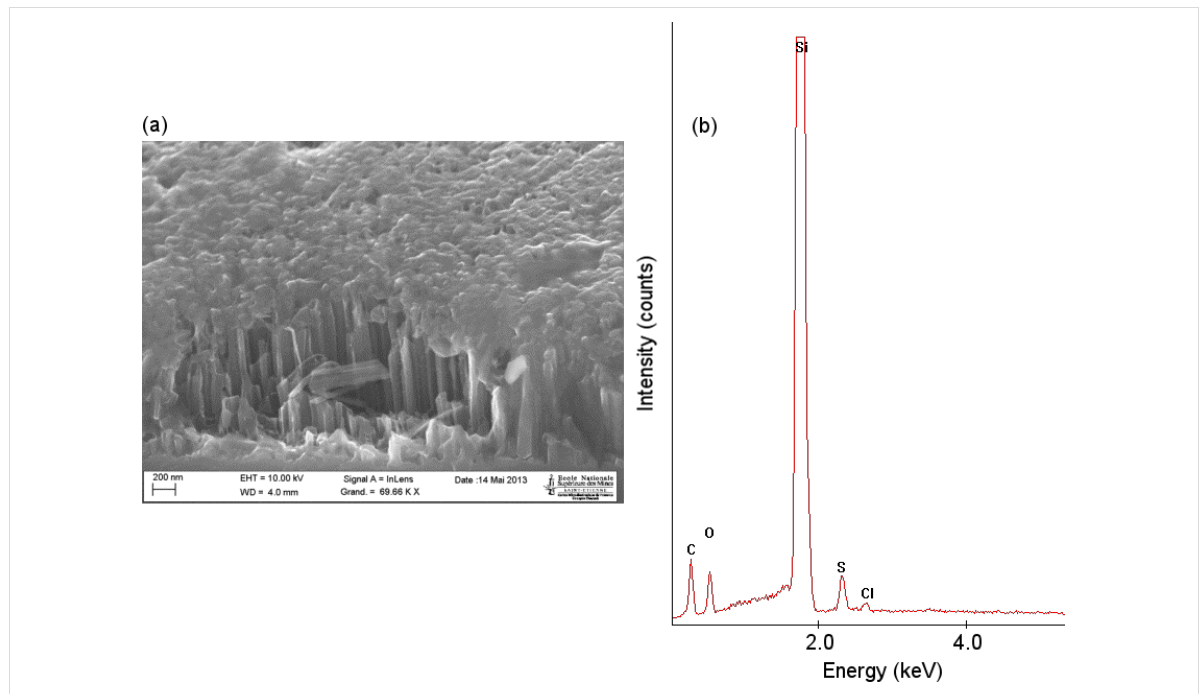
Figure 9: (a) SEM tilted-view of PEDOT covering the top of a SiNW array after 5 s of electrodeposition; (b) corresponding EDX spectrum.